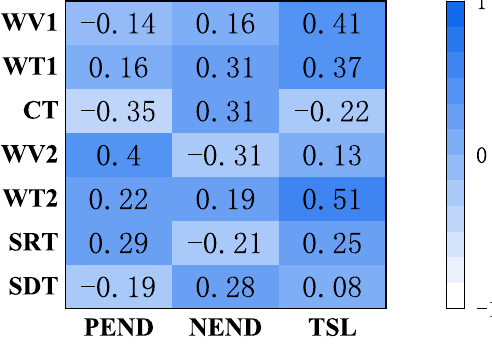
Figure 5. Pearson correlation coefficients.